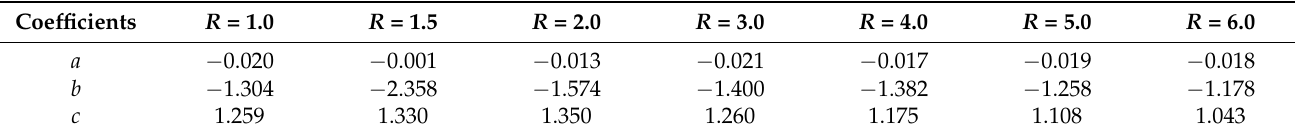
Table 2. Regression coefficients of the equation for DAF max